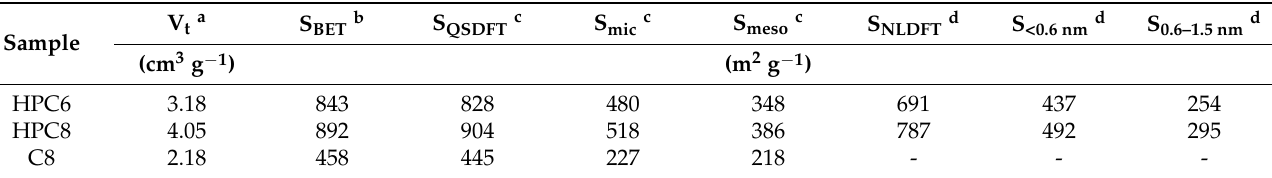
Figure 2. Nitrogen sorption isotherms ( a ), carbon dioxide sorption isotherms (inset in a) and their corresponding pore size distributions ( b ) for HPC6 and HPC8. Table 2. Surface area and pore-structure parameters for